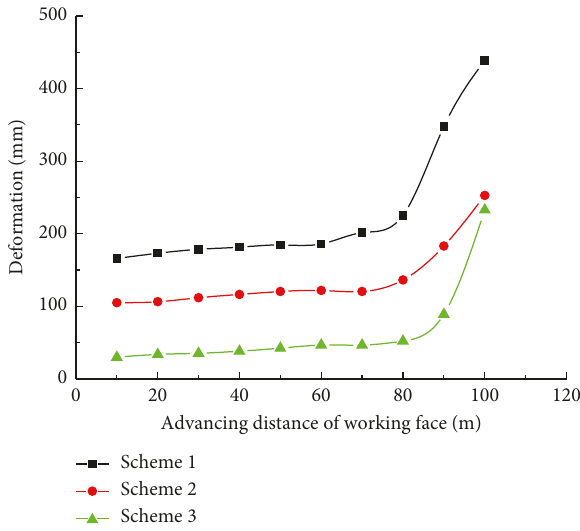
Figure 10: Main retracement channel: minor wall deformation.